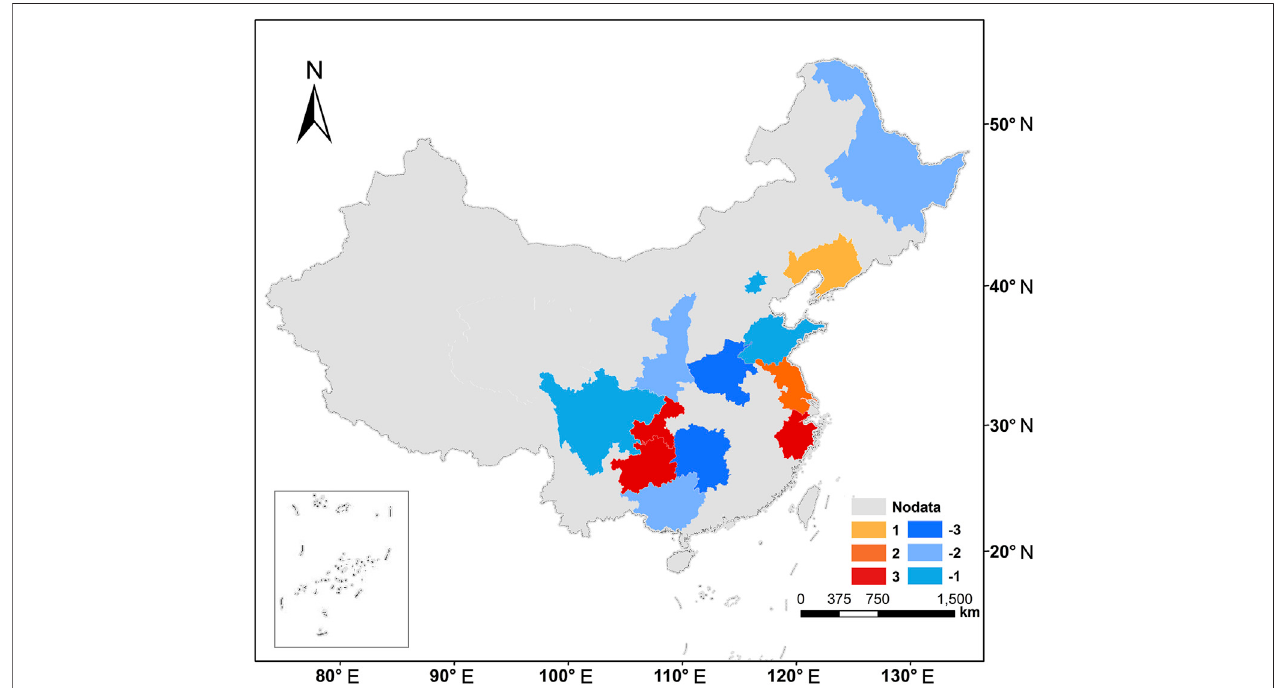
FIGURE 8 | The effect of the ratio of tertiary industry to industry on the length of the growing season. The light gray areas in the fi gures represent the areas with no data. The blue area represents the declining trend, while the red area represents the increasing trend, and the color from light to dark indicates the increasing of signi fi cance ( ± 1: p > 0.05, ± 2: p < 0.05, ± 3: p <